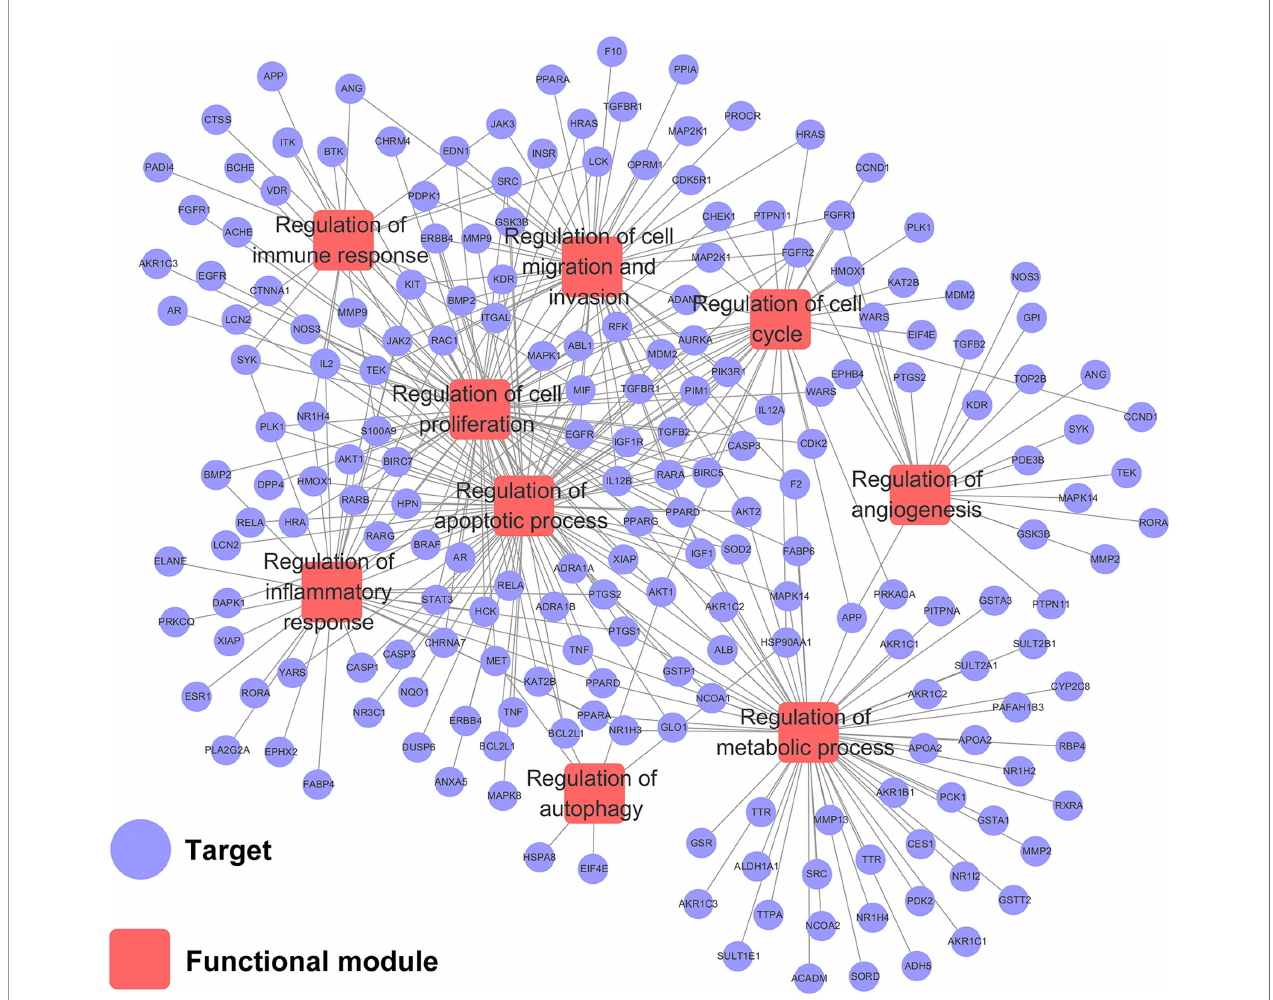
FIGURE 4 | Target-function network. The functional module is connected to the target when the target participates in that biological